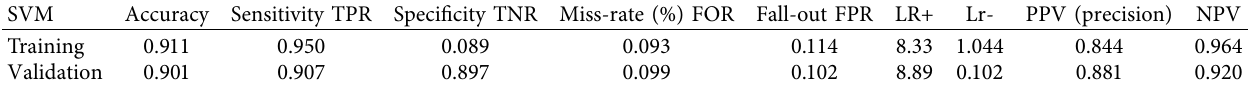
Table 5: Proposed congestion control model performance in training and validation (SVM).